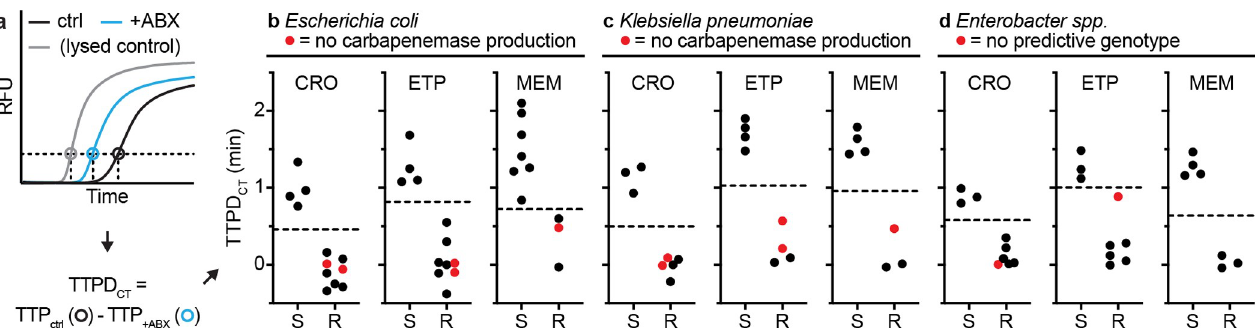
Fig 4. Validation of the pol-aAST method using control and antibiotic-treated aliquots. (a) Example calculation of TTPD between control and treated aliquots (TTPD CT ). The TTP (in minutes) of the control and treated aliquots are used to calculate TTPD CT . (b–d) The pol-aAST results using E . coli (b), K . pneumoniae (c), and Enterobacter spp. (d) isolates exposed to CRO, ETP, and MEM for 15 min. Red points represent isolates with either no detectable carbapenemase genes ( Ec and Kp isolates) according to a published genotypic assay [67] and commercial assay [68] or no predictive genotype ( Ebs isolates) according to the whole genome sequencing by the CDC [66]. S/R thresholds (dashed lines) were set halfway between the lowest susceptible and the highest resistant TTPD CT values. Raw data are provided in S3 Table. +ABX, antibiotic-treated; AST, antibiotic susceptibility testing; CDC, Centers for Disease Control and Prevention; CRO, ceftriaxone; CT, control to treated; ctrl, control; Ebs , E . aerogenes and E . cloacae collectively; Ec , E . coli ; ETP, ertapenem; Kp , K . pneumoniae ; MEM, meropenem; pol-aAST, polymerase-accessibility AST; R, resistant; RFU, relative fluorescent units; S, susceptible; TTP, time-to-positive; TTPD, time-to-positive difference; TTPD CT , TTPD control to treated.